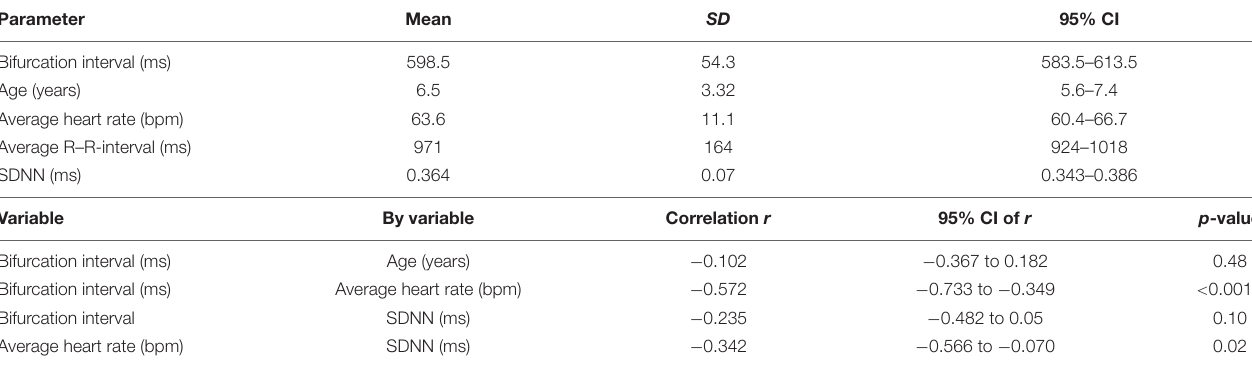
TABLE 3 | Pairwise correlation of bifurcation interval measured during stable sleep hour in 50 dogs* with heart rate, R–R-interval, rate corrected SDNN, and